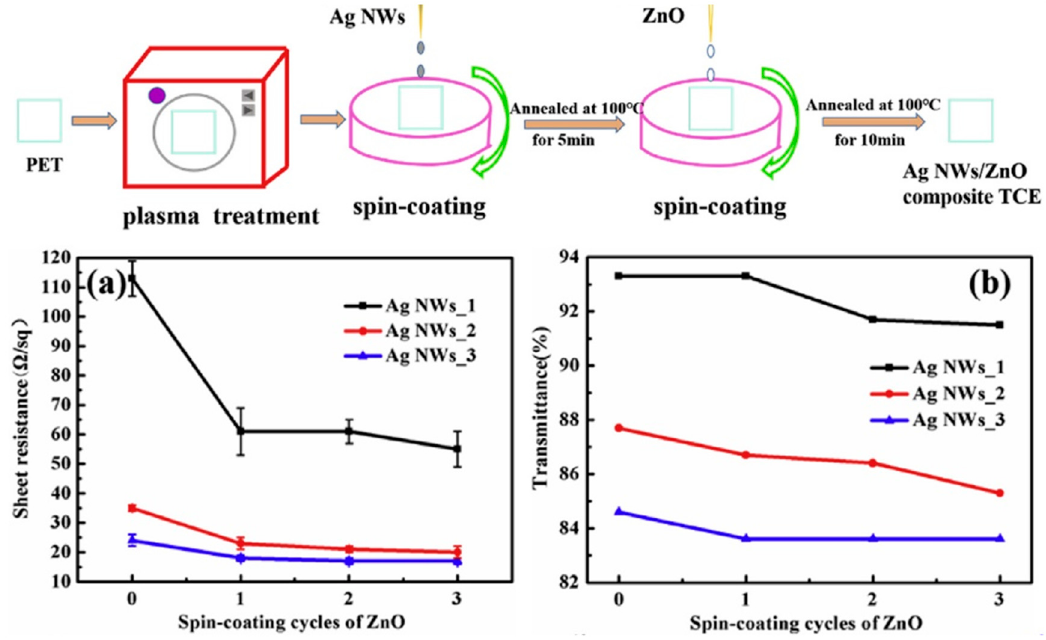
Figure 3. The schematic illustration of the preparation of Ag NWs/ZnO composite TCE and the sheet resistance, transmittance at 550 nm and figure of merit for the Ag NWs TCEs with different spin- coating cycles of ZnO, respectively [91]. Copyright 2018, Journal of Alloys and Compounds.